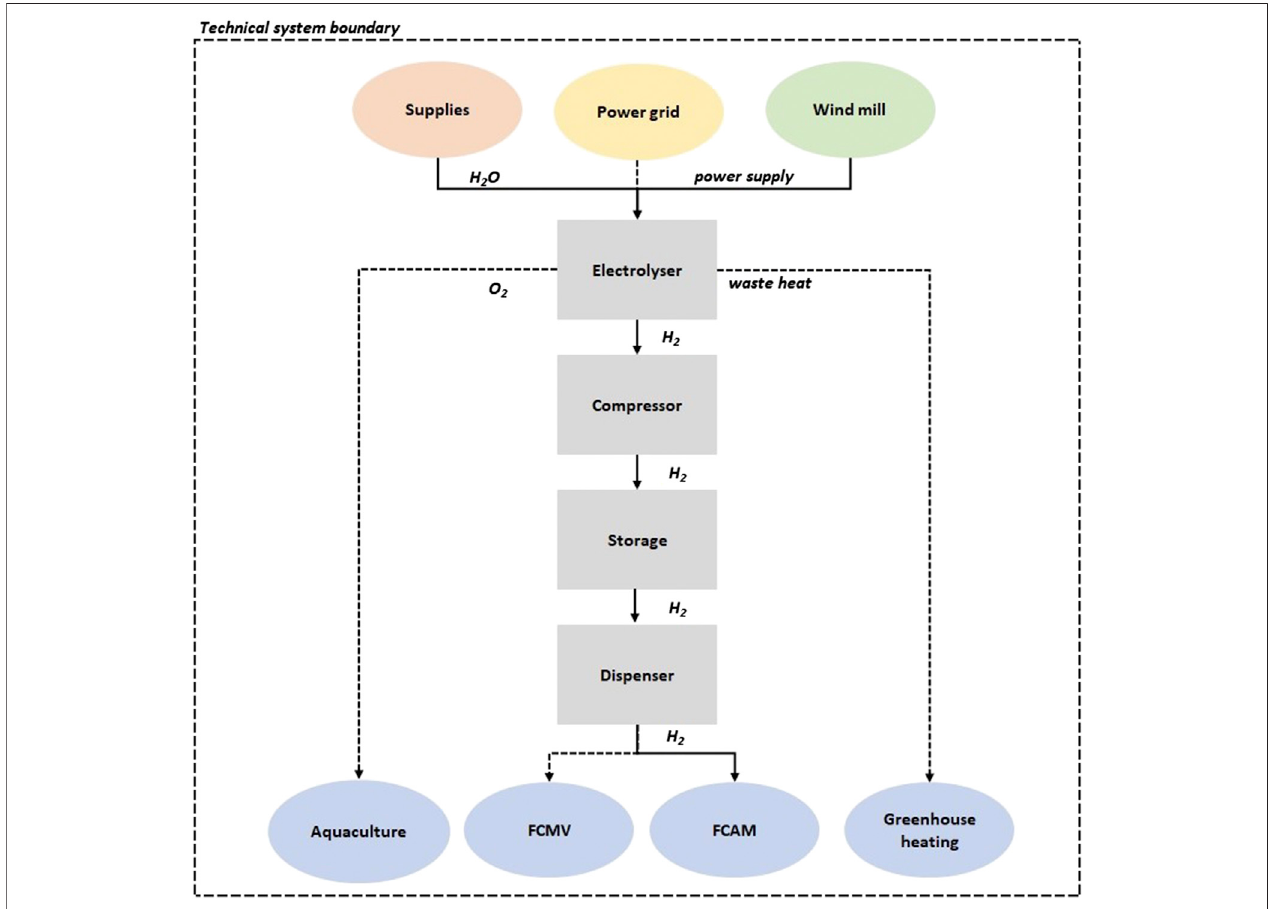
FIGURE1| Schematicdiagramofthetechnicalsystemboundary.Note:DottedarrowlinesrepresentoptionalH 2 and/orby-productsuse;FCMV-fuelcellminivan; FCAM - fuel cell agricultural machinery.